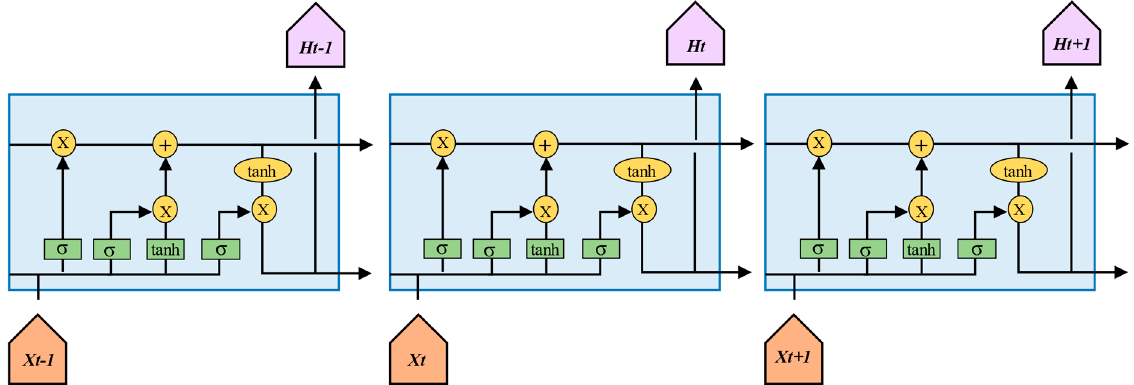
Figure 5. Long short-term memory (LSTM) structure.